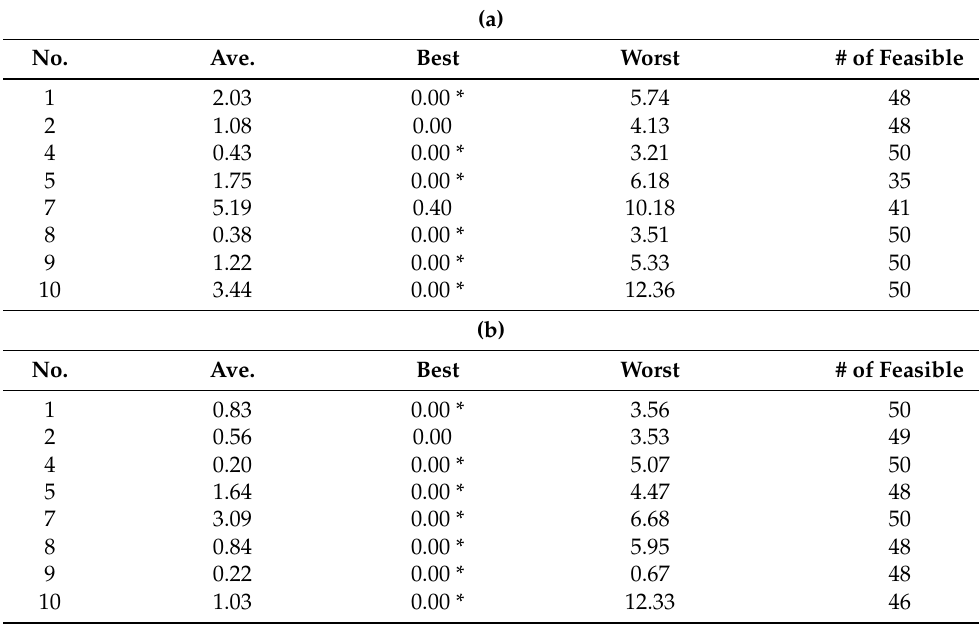
Table 7. Results of gaps in the method that dynamically adjusts weights for n = 30. Feasible solutions of instances 3 and 6 cannot be obtained by the latest version of the Gurobi optimizer 9.1.1 within 12 h. Symbol “*” means that an optimal solution can be obtained using the Gurobi optimizer 9.1.1 within 12 h. ( a ) Method 1 (Equations (20) and (21)). ( b ) Method 2 (Equations (22) and (23)).